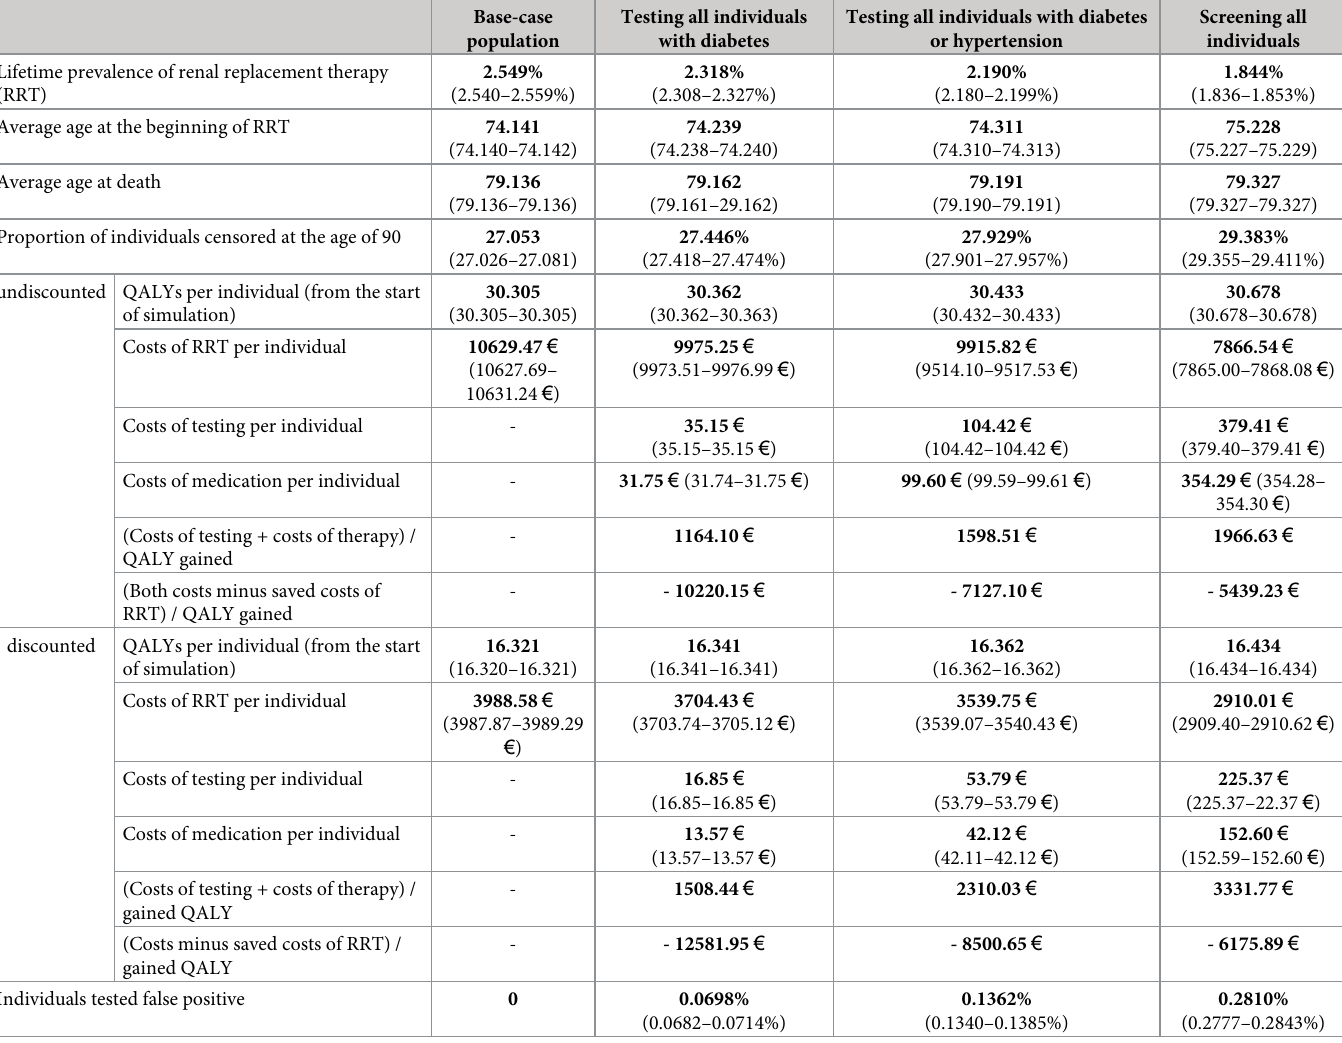
Table 2. Comparison of 10 million individuals without intervention compared to 3 scenarios of testing/screening and